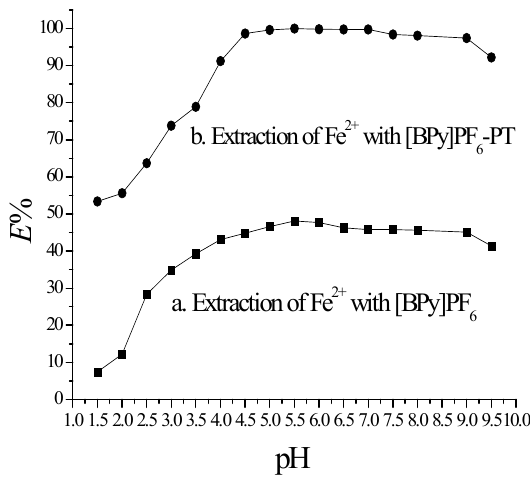
Figure 1. Plot of %E as a function of pH in TC-SLE system. Conditions: IL phase, 1 g [BPy]PF 6 , [PT] IL = 8.10 × 10 − 3 mol·L − 1 ; Aqueous phase, [Fe 2+ ] = 1.0 × 10 − 5 mol·L − 1 .